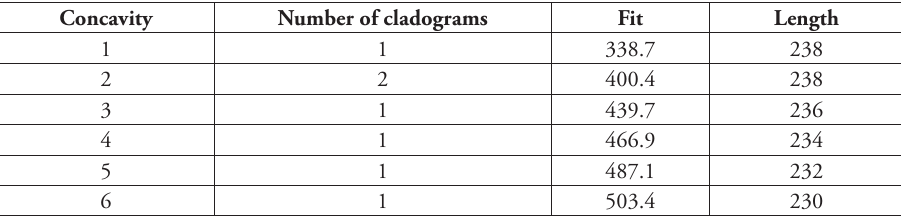
Table 3. Length, fit and number of cladograms obtained using implied weights and different concavities on